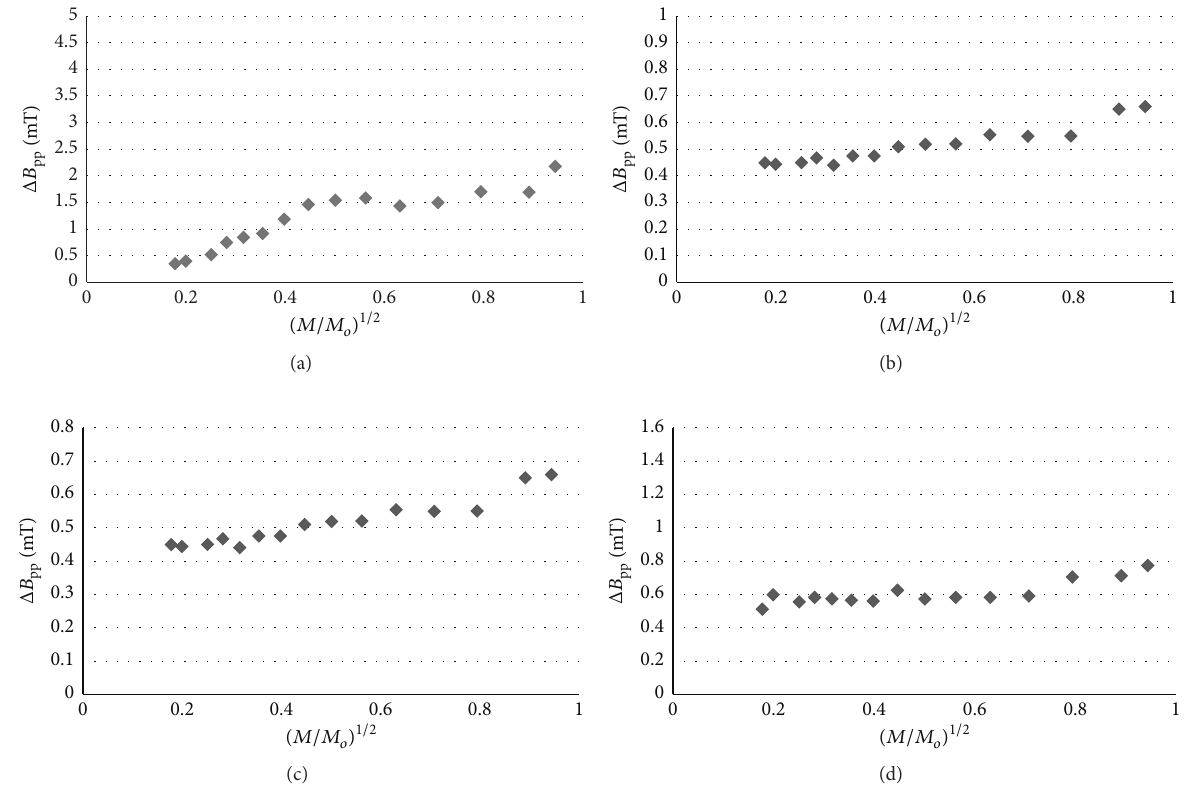
Figure 8: The effect of microwave power ( 𝑀/𝑀 𝑜 ) linewidths ( Δ𝐵 pp ) of the EPR spectra of UV irradiated urea during (a) 15 minutes, (b) 30 minutes, (c) 45 minutes, and (d) 60 minutes. 𝑀 : microwave power used during the measurement and 𝑀 𝑜 : total microwave power produced by klystron (70mW).